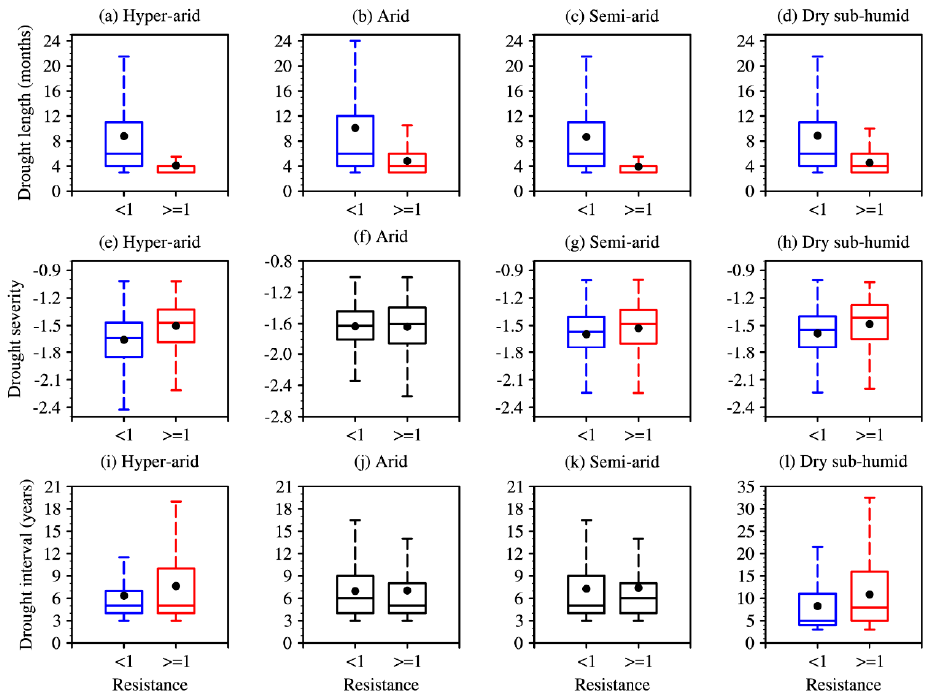
Figure 6. Differences in ( a – d ) drought length, ( e – h ) severity, and ( i – l ) interval corresponding to complete (resistance ≥ 1) or incomplete (resistance < 1) resistance in ( a , e , i ) hyper-arid, ( b , f , j ) arid, ( c , g , k ) semi-arid, and ( d , h , l ) dry sub-humid regions. Black dots indicate average values. Black boxes indicate a non-significant difference, while the red and blue boxes indicate significant